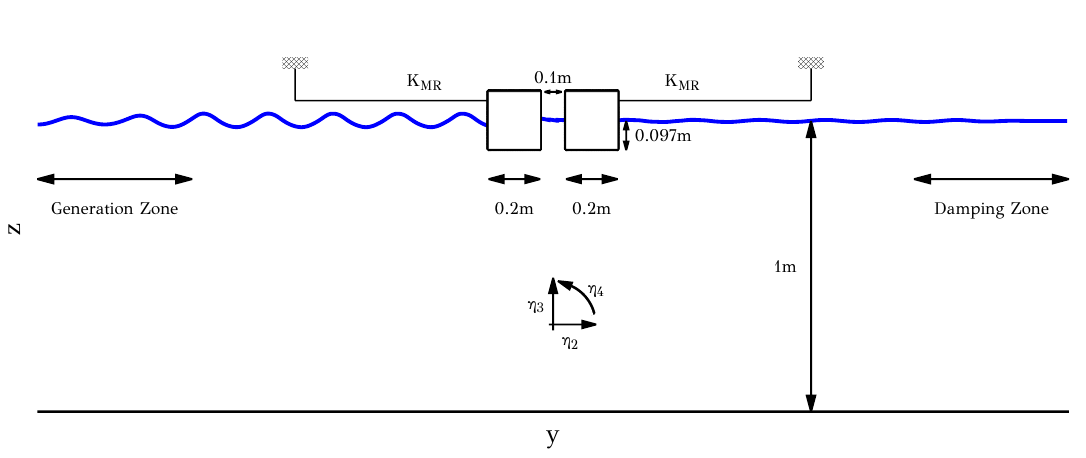
Figure 9. Numerical setup for the moonpool-type floater test